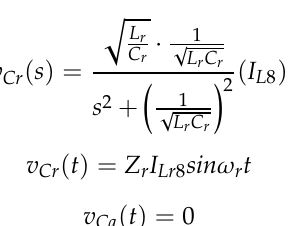
Figure 10. The equivalent circuit of Mode 7 and key waveform.